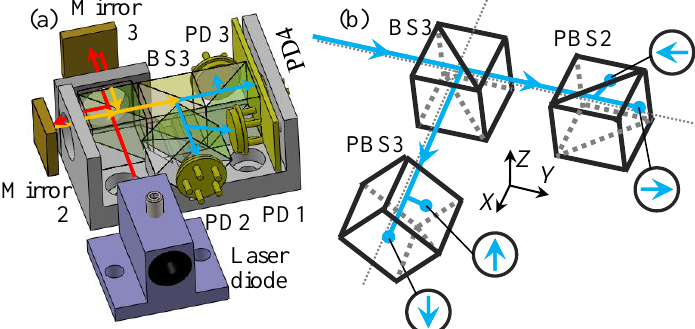
Figure 3. Optical layout of the miniature Michelson interferometer (MMI) kit: ( a ) three-dimensional (3D) image; ( b ) geometric configuration of generating four interference fringes with 90° phase shift.